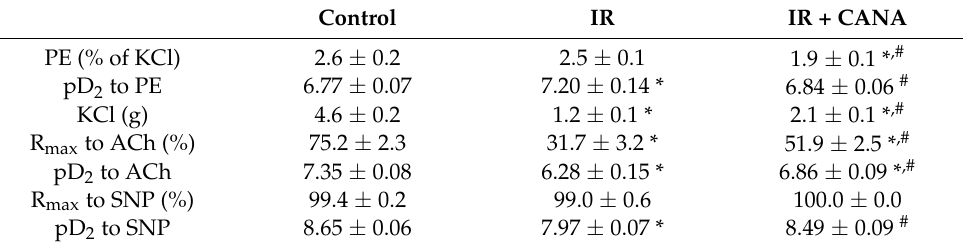
Figure 1. Effect of canagliflozin (CANA) on contractile and relaxation responses after vascular ischemia/reperfusion (IR) injury. ( A ) Acetylcholine-induced endothelium-dependent and ( B ) sodium nitroprusside-induced endothelium- independent vasorelaxation, and contractile responses ( C ) to phenylephrine (percentage of the maximum contraction induced by potassium chloride (KCl)) and ( D ) to high potassium-induced depolarization of isolated aortic rings. Results are represented as mean ± SEM. * p < 0.05 versus Control; # p < 0.05 versus IR. n = 18–43 aortic rings from 8–11 rats. Table 1. Quantitative analysis of vascular function after ischemia/reperfusion (IR) injury. Data are represented as mean ± SEM. CANA indicates canagliflozin; PE, phenylephrine as the percentage of the maximum contraction induced by potassium chloride (KCl); ACh, acetylcholine; SNP, sodium nitroprusside; R max , maximal relaxation, and pD 2 , negative logarithm of the corresponding half- maximal response (EC 50 ). * p < 0.05 versus Control; # p < 0.05 versus IR. n = 18–43 aortic rings from 8–11 rats.